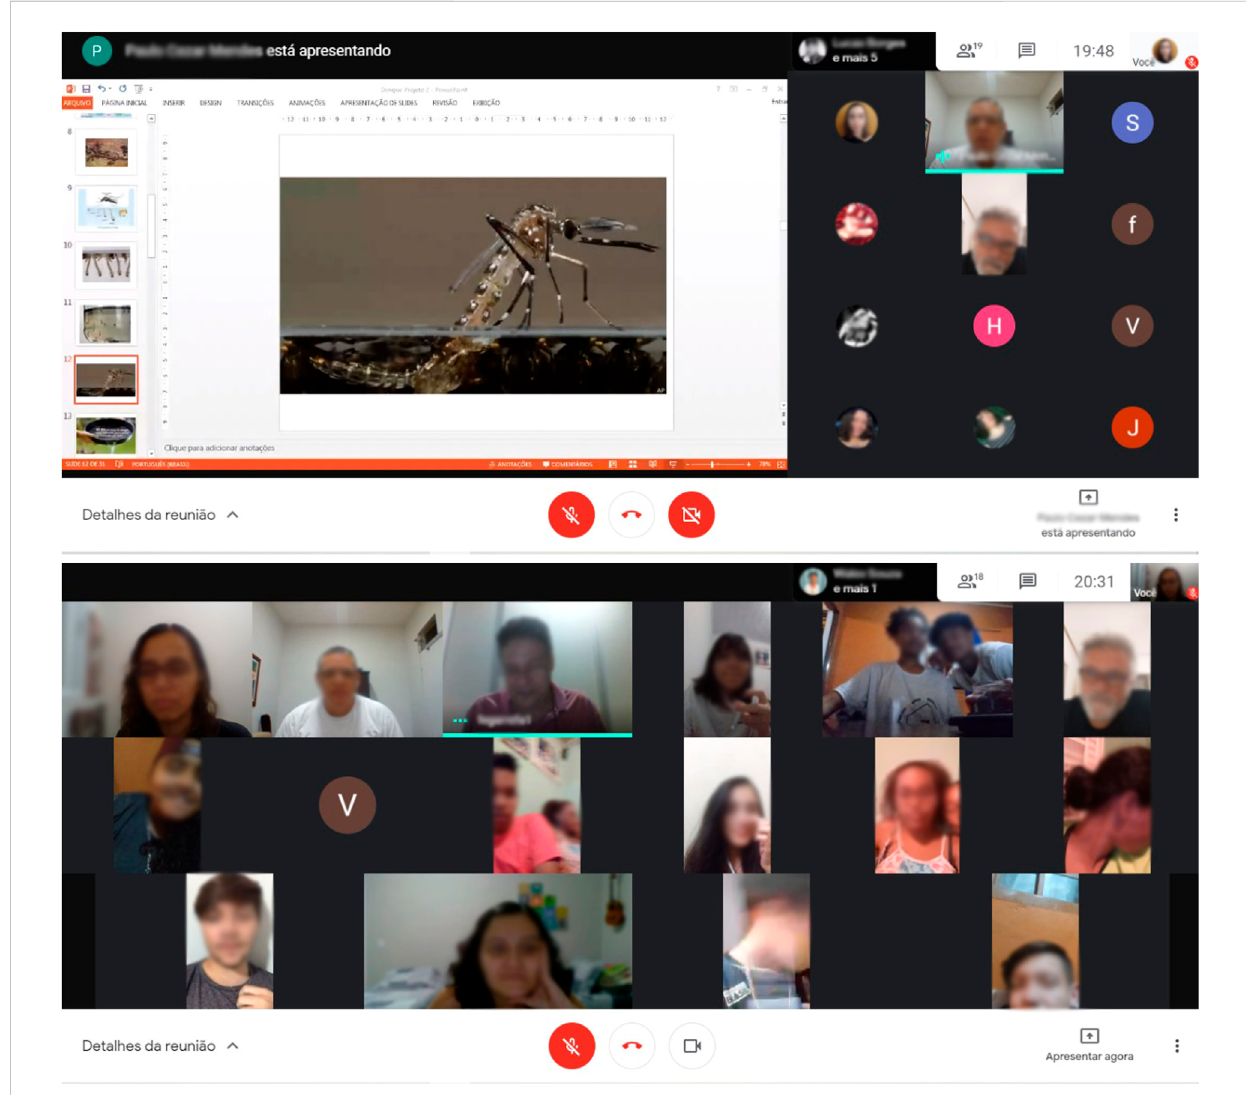
FIGURE 7 Workshop 2A with students ’ screen registrations.